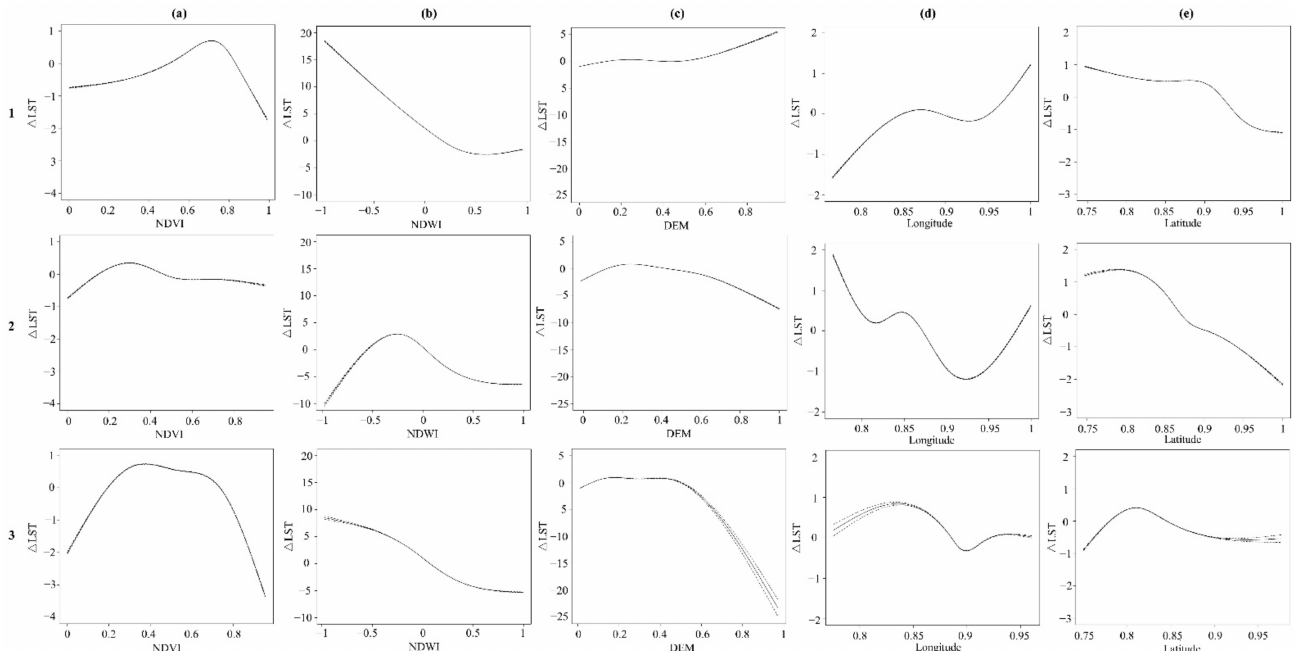
Figure 6. GAM analysis in the growing season: partial dependence plots of ∆ LST for three land covers with five covariates: forest (1st row), grassland (2nd row), and agriculture land (3rd row). The columns represent the five covariates: NDVI ( a ), NDWI ( b ), DEM ( c ), longitude ( d ), and latitude ( e